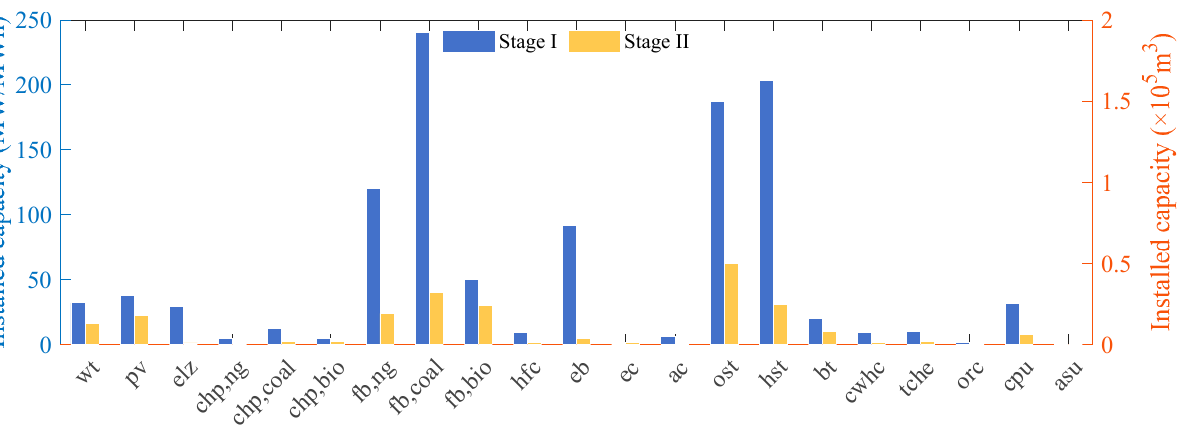
Figure 4. Installed Capacity of Equipment in Two Stages of Case 1.